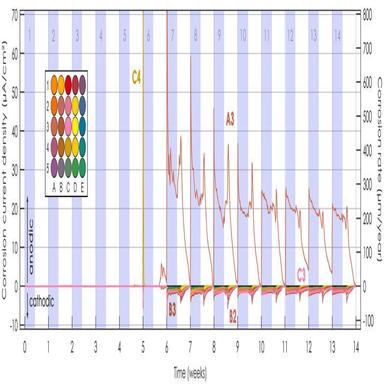
Anodic and cathodic currents for the CEM I specimen over 14 weeks of exposure to cyclic wetting and drying.